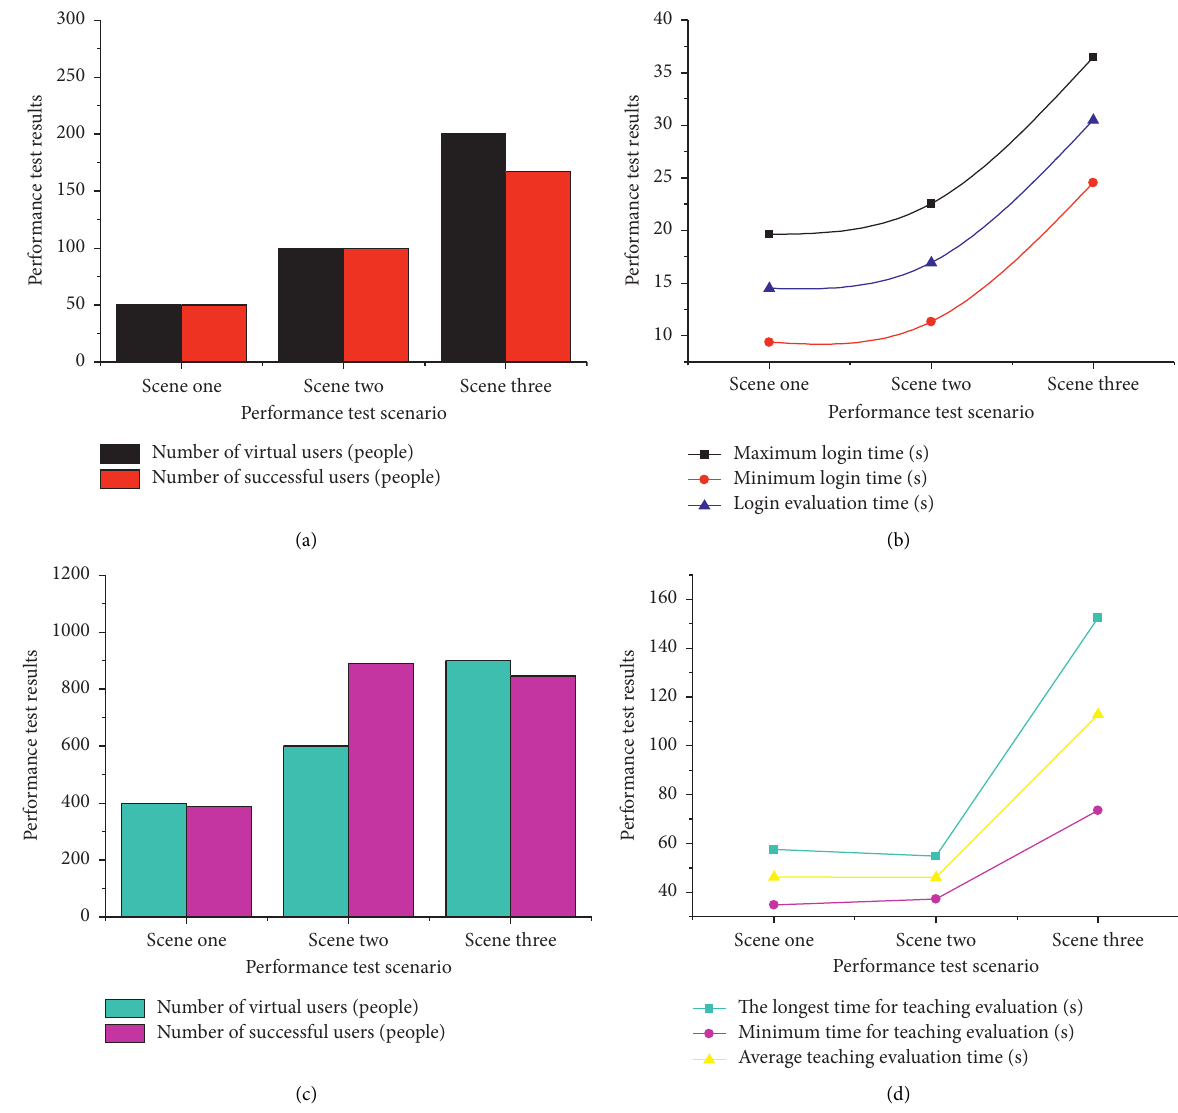
Figure 7: Stress load test results. (a) Log in system. (b) Log in system. (c) Teaching evaluation system. (d) Teaching evaluation